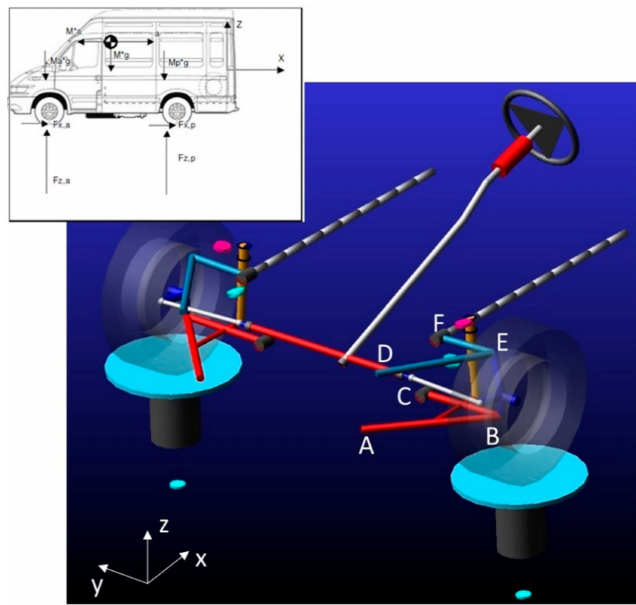
Figure 3. Load at wheels input and MSC / AdamsCar suspension system model.